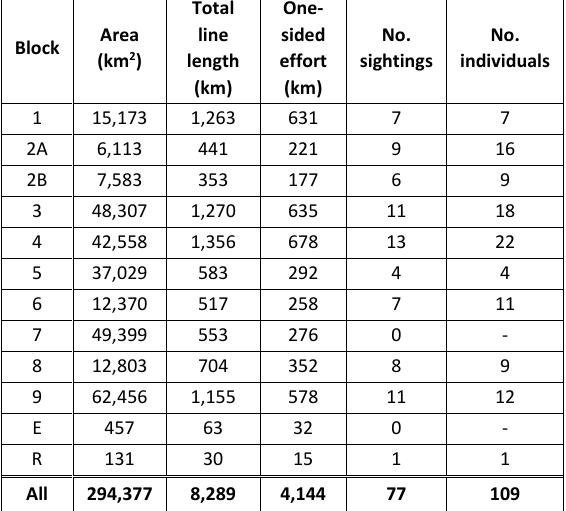
Table 1. Surface area of blocks, realised effort for the 2007 Icelandic aerial survey, and overview of harbour porpoise sightings. Only effort in good or moderate porpoise sighting conditions and only harbour porpoise sightings by the experienced porpoise observer are shown.